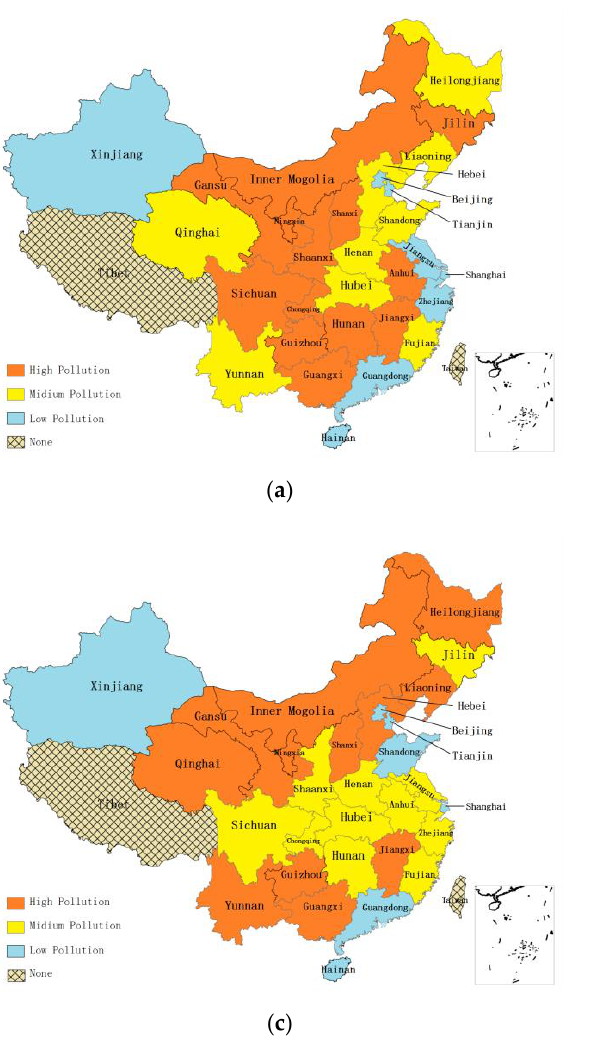
Figure 3. Industrial pollution distribution. ( a ) Industrial pollution in 2006. ( b ) Industrial pollution in 2010. ( c ) Industrial pollution in 2014. ( d ) Industrial pollution in 2018.